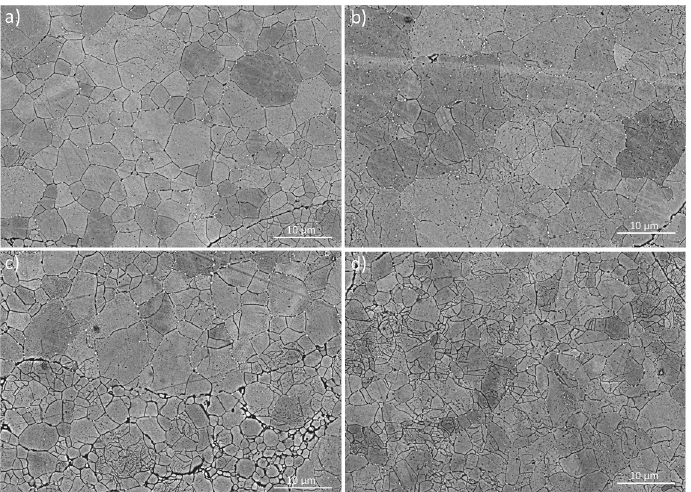
Figure 8. Microstructures of samples sintered by ERS under ( a ) 8 kA and 500 ms and ( b ), ( c ), and ( d ) 7.5 kA and 300, 500, and 700 ms, respectively.